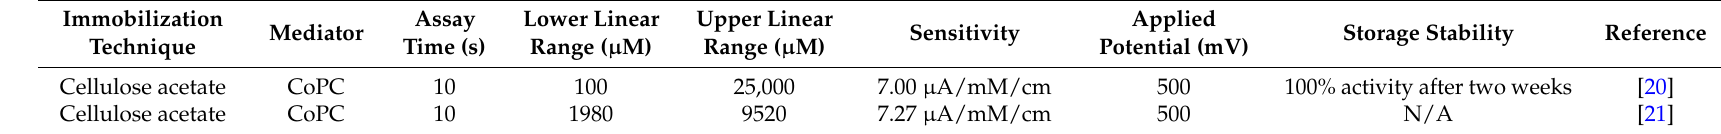
Table 2. Reports of screen-printed carbon electrodes for galactose determination.